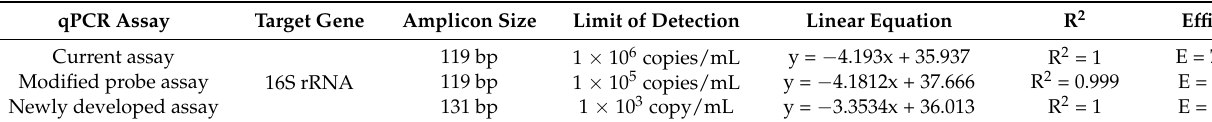
Table 4. Limits of detection and standard curve results of the three qPCRs.